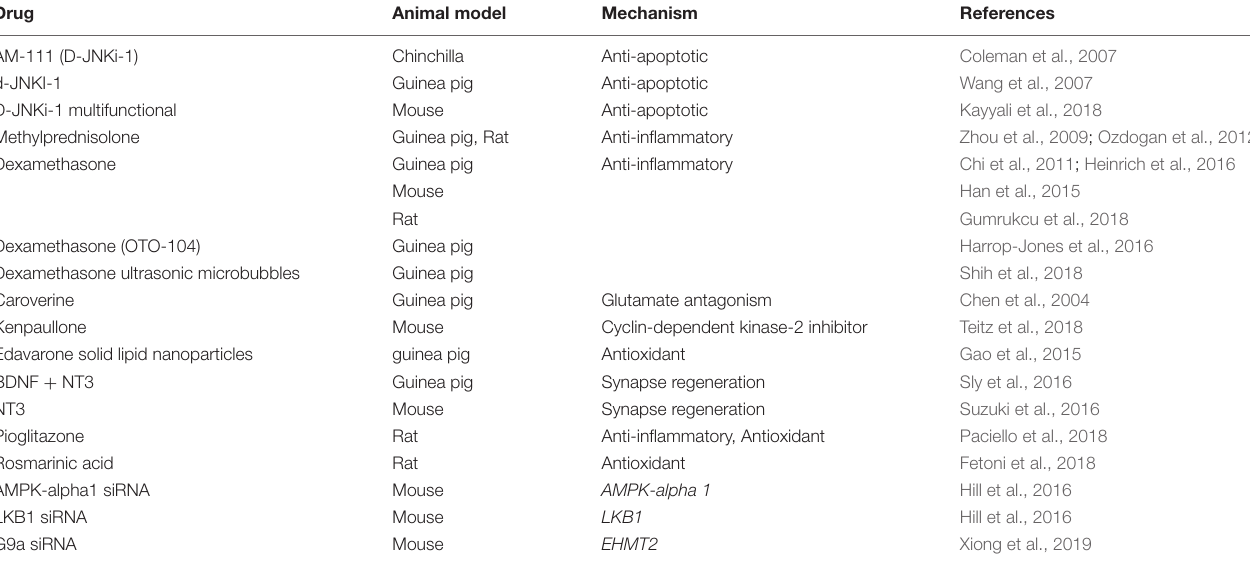
TABLE 2 | This table summarizes pertinent studies of amelioration of noise-induced hearing loss using intra-tympanic